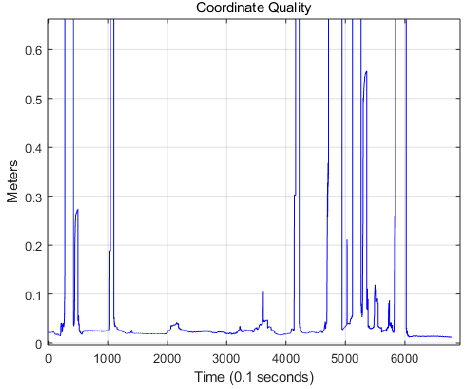
Figure 10. Coordinate quality (CQ) of Ekinox2-D RTK/INS.